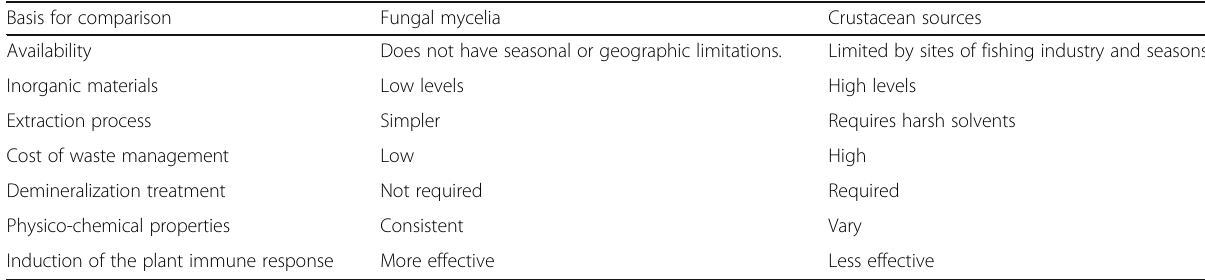
Table 1 Comparison between chitin and chitosan production from fungal mycelia and crustacean sources Basis for